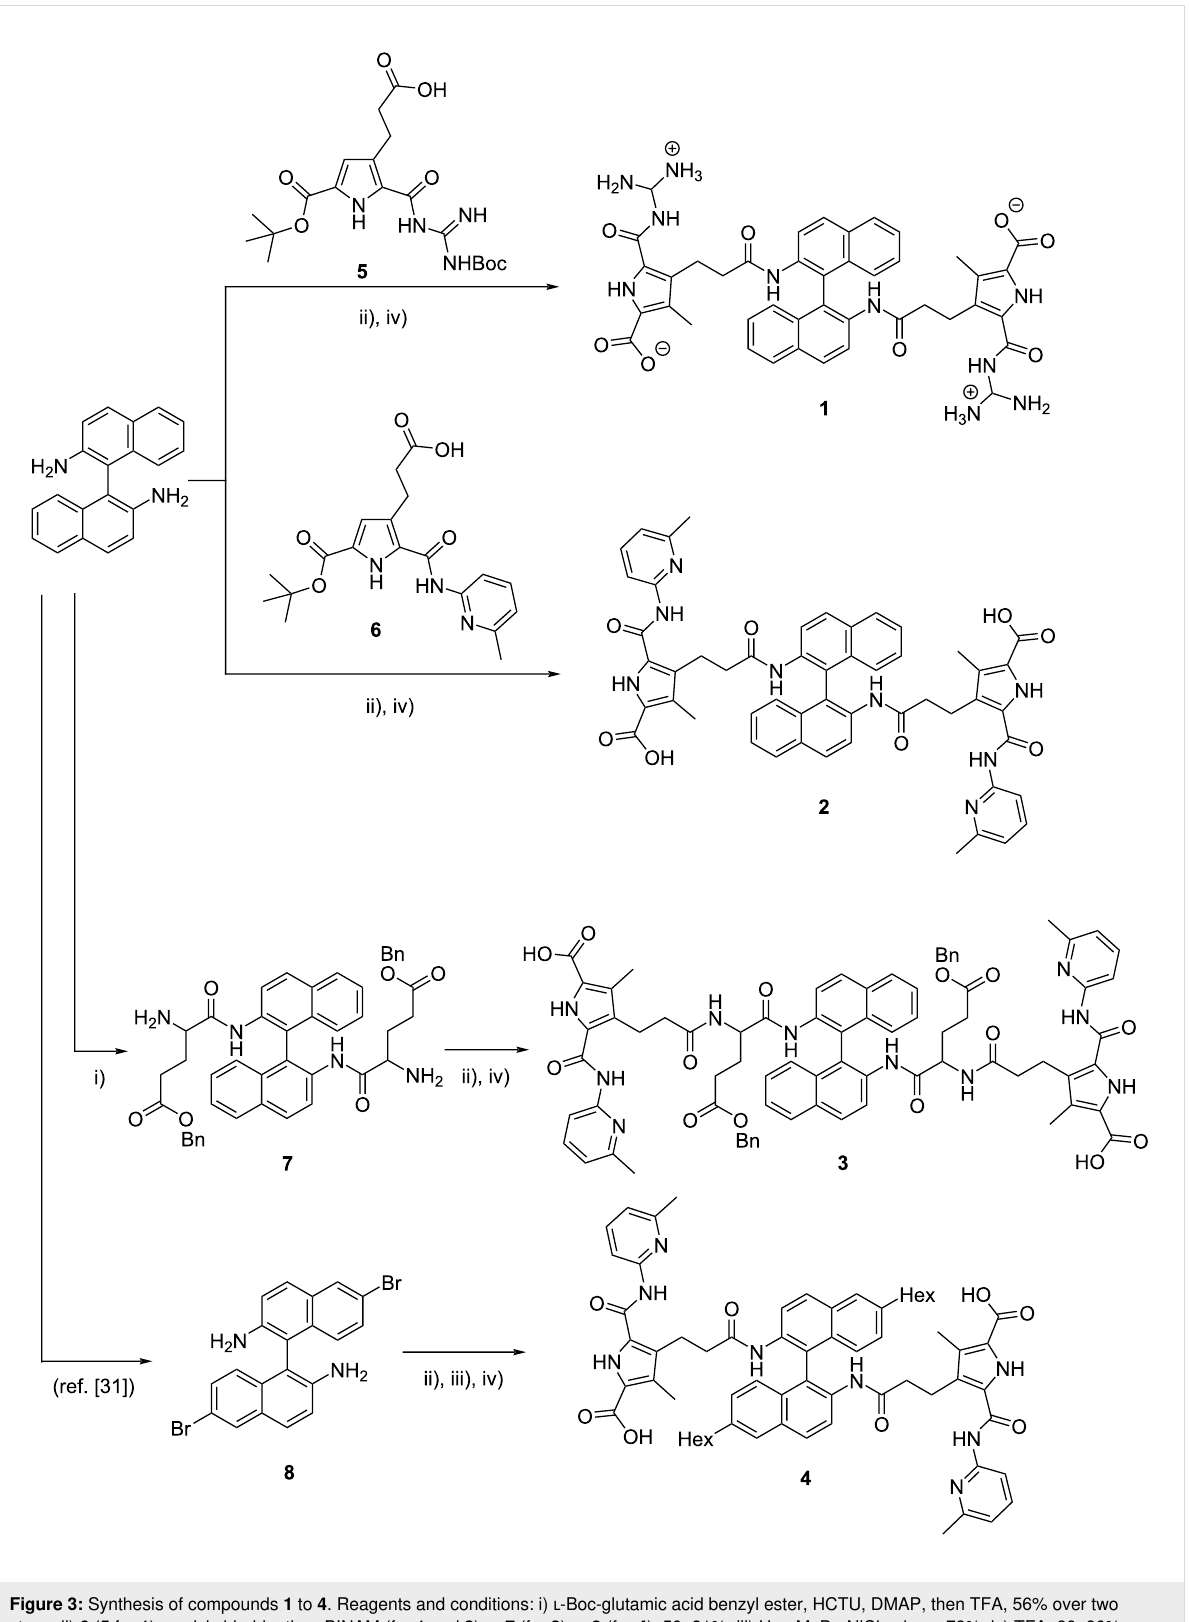
Figure 3: Synthesis of compounds 1 to 4 . Reagents and conditions: i) ʟ -Boc-glutamic acid benzyl ester, HCTU, DMAP, then TFA, 56% over two steps; ii) 6 ( 5 for 1 ), oxalyl chloride, then BINAM (for 1 and 2 ) or 7 (for 3 ) or 8 (for 4 ), 50–81%; iii) Hex-MgBr, NiCl 2 , dppp, 78%; iv) TFA,